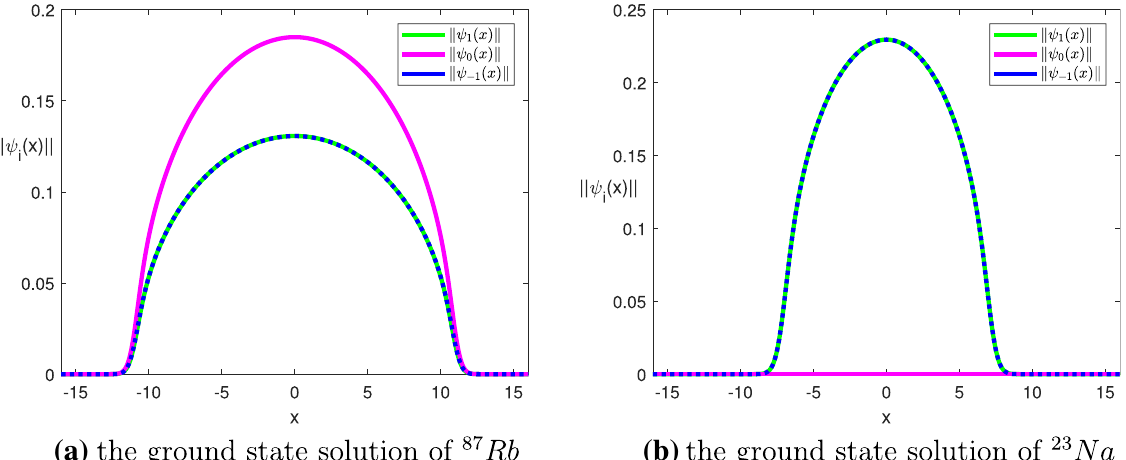
0.0005 for 87 Rb and k 0 =